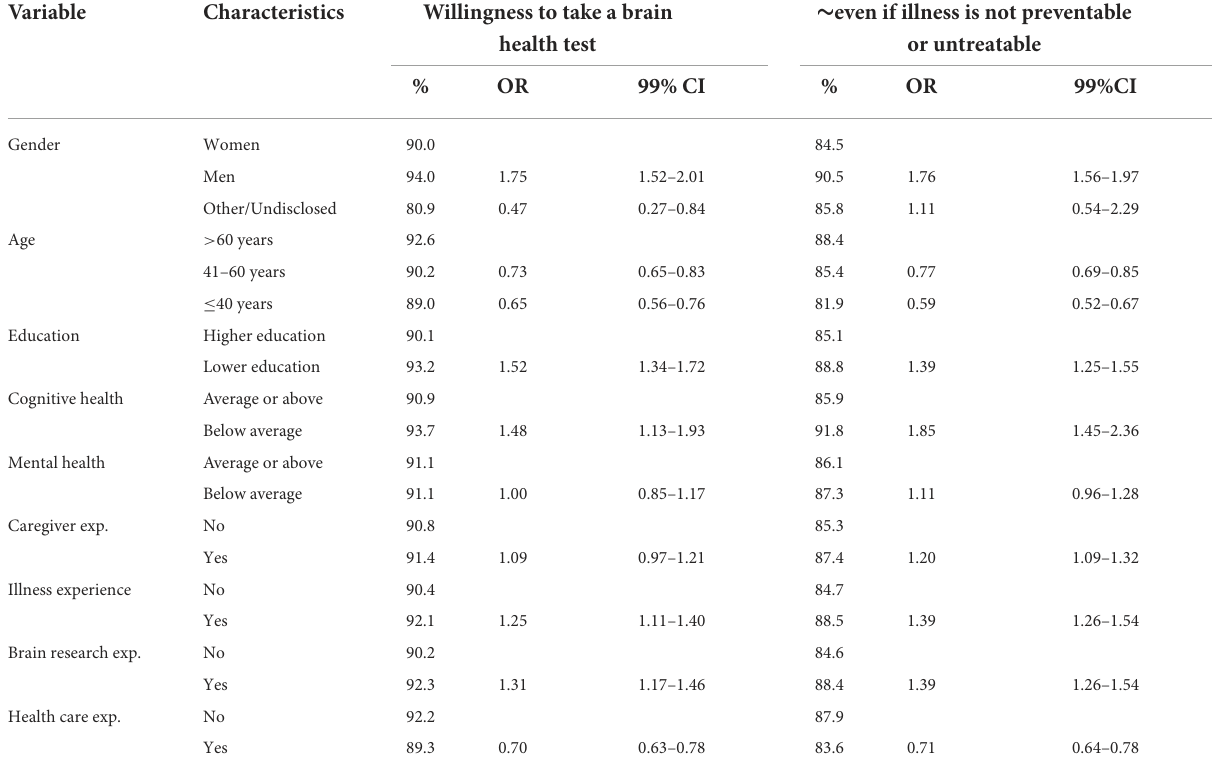
TABLE 1 Probability of taking a brain health test (question 1), and probability of taking a test even if it provides information about a disease that cannot be prevented or treated (question 2), by demographic groups. Variable